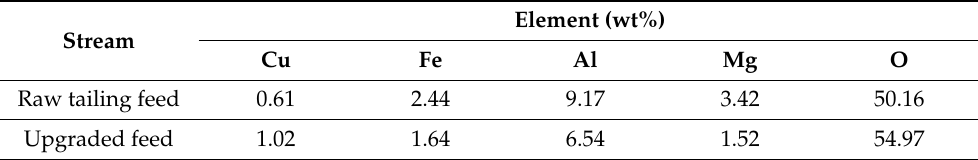
Table 11. Elemental composition of the raw tailing feed and upgraded feed [22].